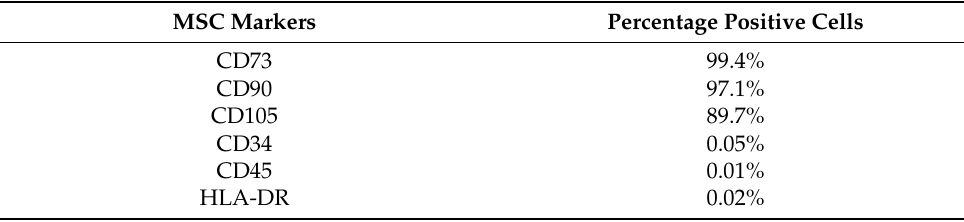
Table 2. Flow cytometry analysis of MSC specific markers in